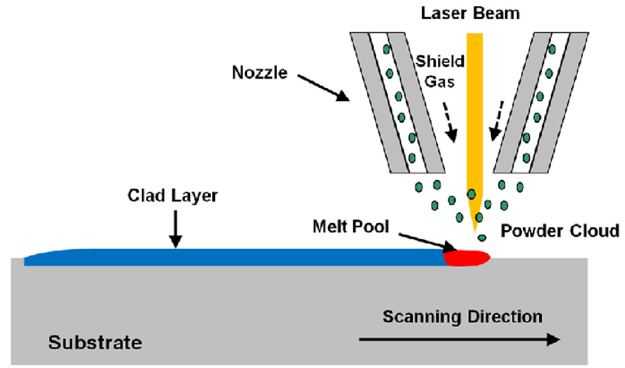
Figure 2. Setup schematic of the coaxial laser cladding process.